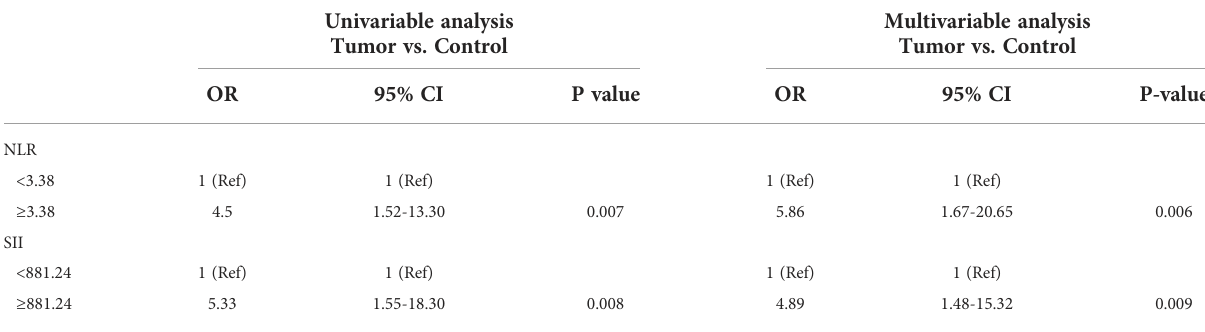
TABLE 4 Univariable and multivariable analyses for predicting testicular germ cell tumors. Univariable analysis Multivariable analysis Tumor vs. Control Tumor vs. Control